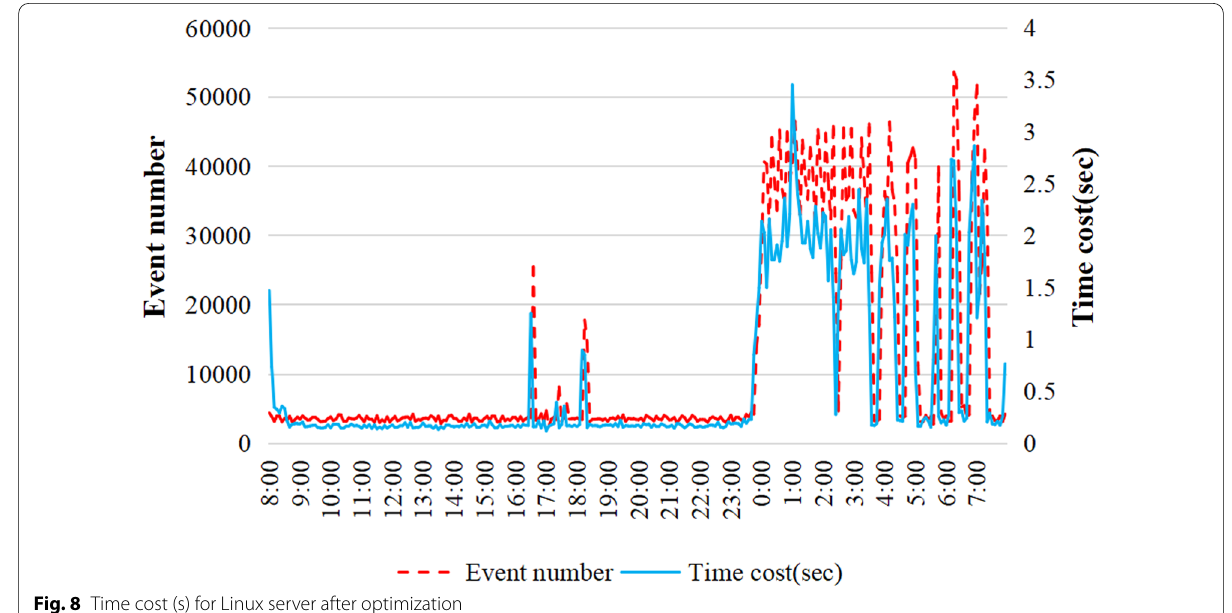
Fig. 8 Time cost (s) for Linux server after optimization